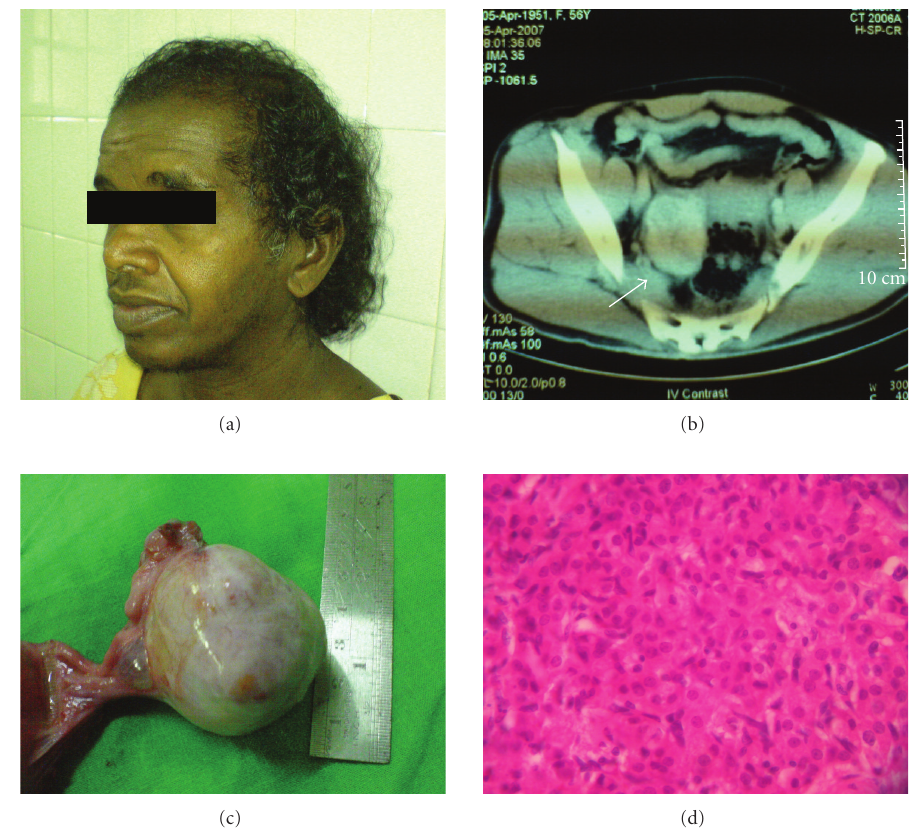
Figure 1: (a) On examination, she had alopecia, frontal balding, and hirsuitism giving a score of 14 from modified Ferriman and Gallwey scoring system. (b) Computed tomography of the abdomen and pelvis revealed a well-defined solid tumor in right adnexal region (arrow). (c) Laparotomy revealed a solid ovarian tumor of 5cm with an intact capsule in the right ovary. (d) Haematoxyline and eosine-stained sections (magnification 10 × 100) revealed cell nets comprising uniform cells with round bland nuclei and eosinophilic cytoplasm. They were surrounded by a proliferation of elongated spindle